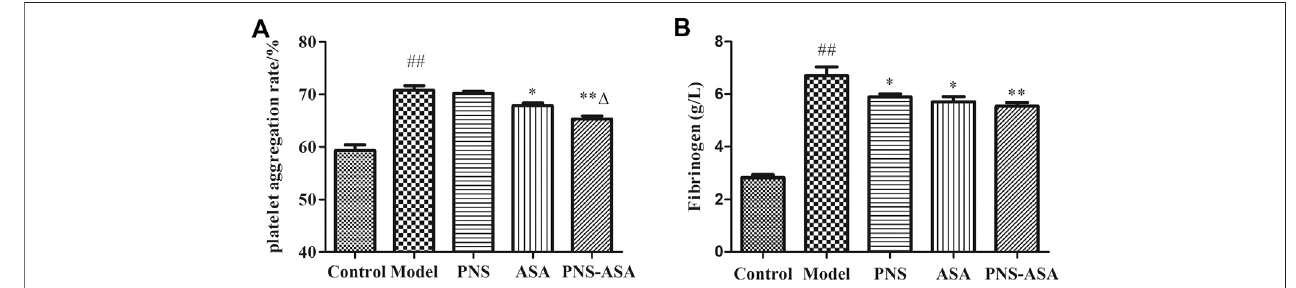
FIGURE 3 | Effects of combined use of PNS and ASA on the rate of platelet aggregation (A) and the content of fi brinogen (B) in rats with acute blood stasis. Data were represented as mean ± SD ( n (cid:2) 8). *p < 0.05 and **p < 0.01 compared with the model group; Δ p < 0.05 compared with the ASA group; ## p < 0.01 compared with the control group.